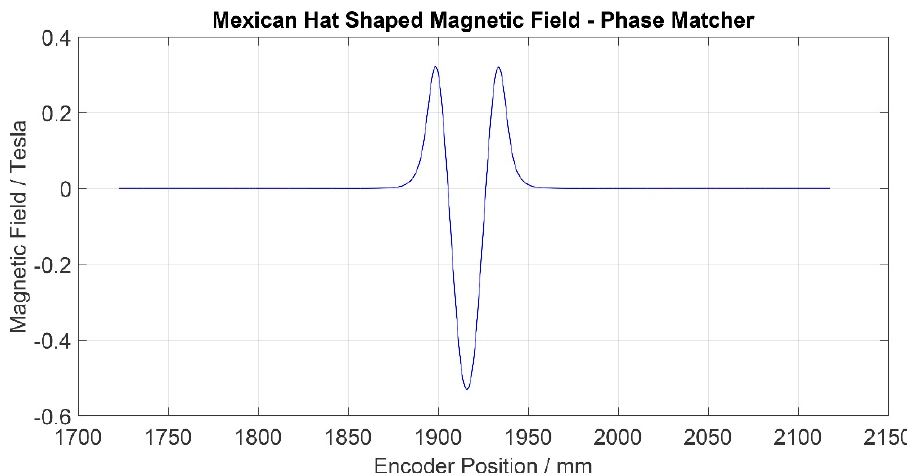
Figure 10. The response of the instrument output when traversing the magnet array with a Mexican hat shaped magnetic field with peak values of 0.3 and − 0.55 T.